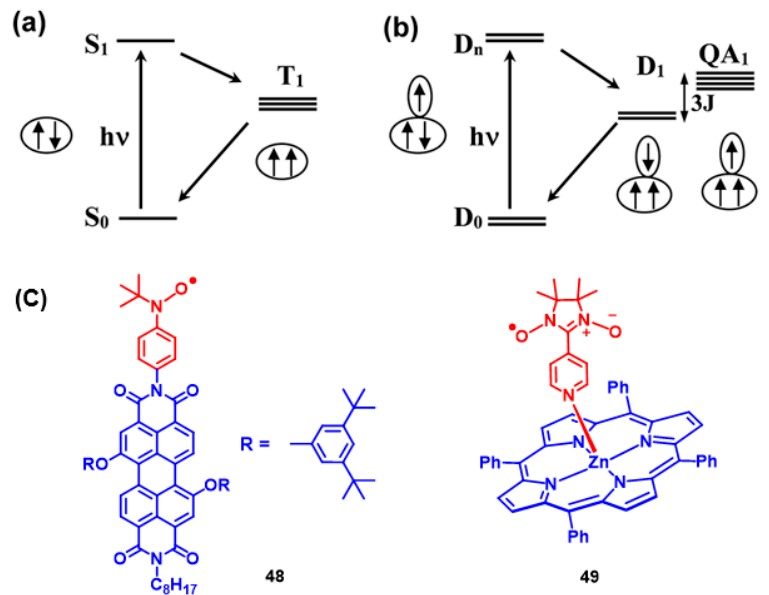
Figure 15. Simplified energy diagrams showing ( a ) the electron spin forbidden ISC in organic chromophore and ( b ) the electron spin allowed ISC of the chromophore in a chromophore-radical three electron spin system. Reproduced with permission from reference [101], copyright 2001, American Chemical Society. ( c ) Molecular structures of some typical radical-chromophore triplet PSs.